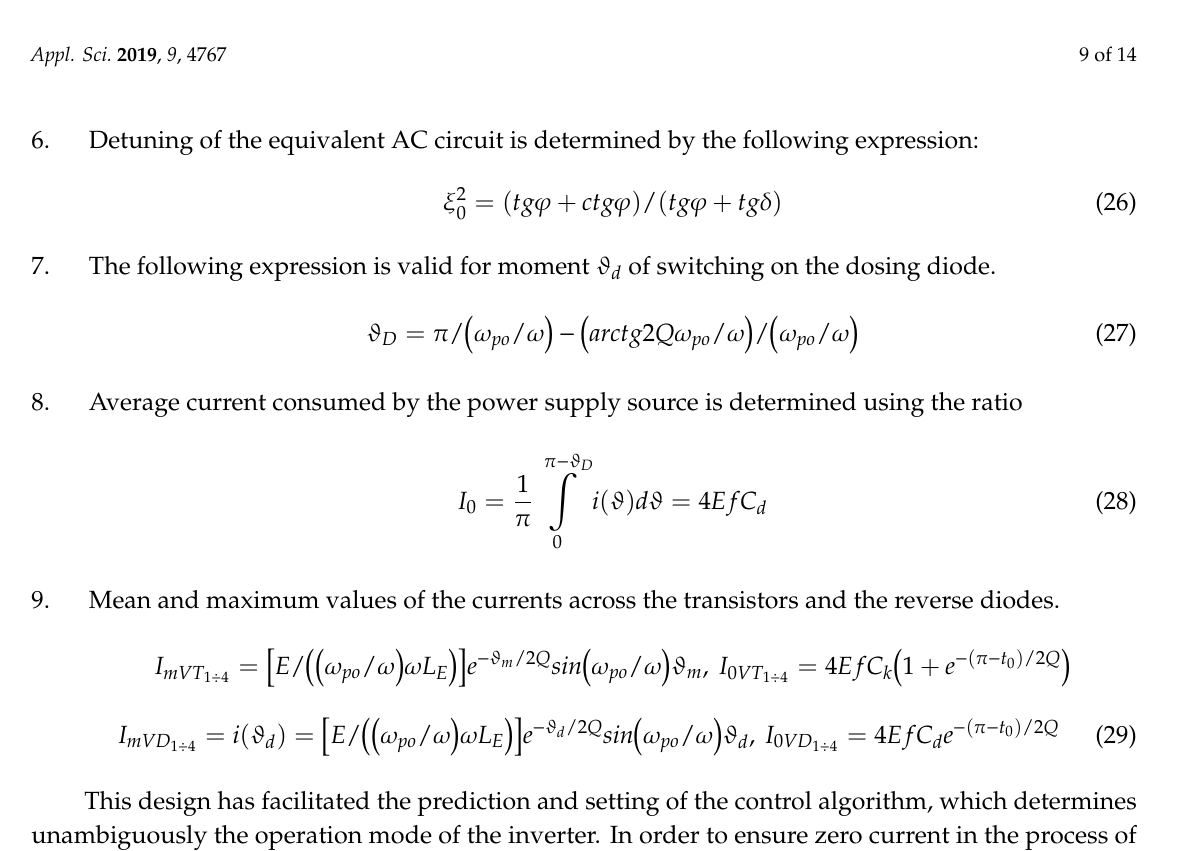
Table 2. IPT dimensions (all dimensions are in mm).